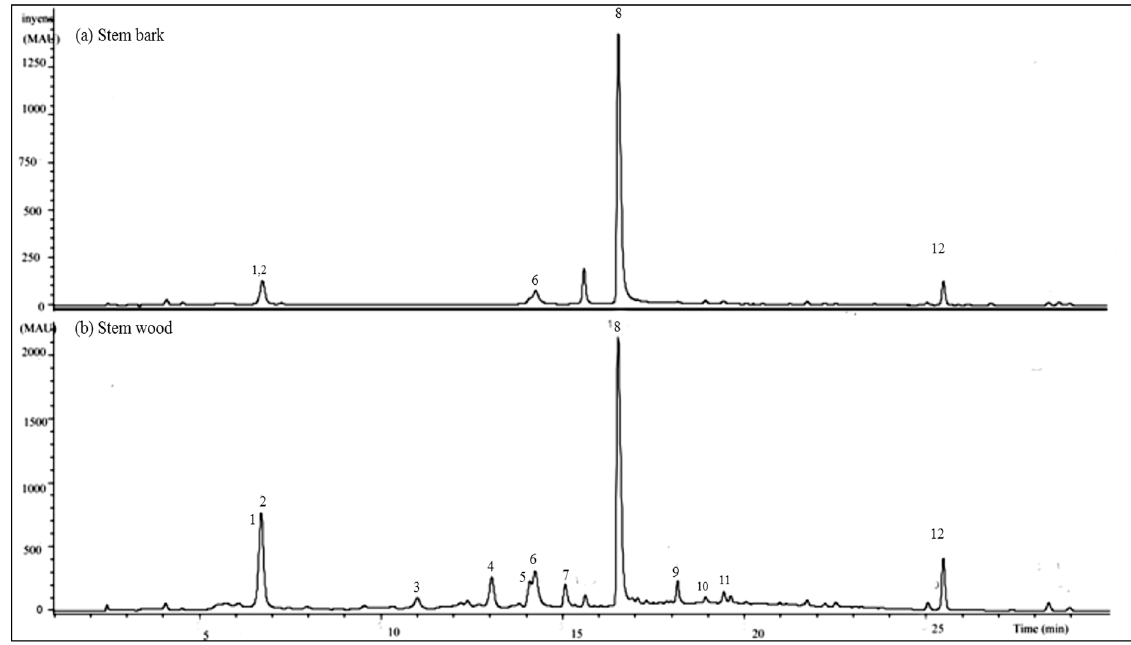
Figure 3. RP-HPLC/DAD chromatograms of ethyl acetate extracts of T.brownii . ( A ) stem bark and ( B ) stem wood extracts at 254 nm. ( 1 ) and ( 2 ) Oleanane type triterpenoids; ( 3 ) cis-resveratrol-3- O - β -galloyl-glucoside; ( 4 ) trans-resveratrol-3- O - β -galloyl-glucoside; ( 5 ) Methyl-( S ) - flavogallonate; ( 6 ) Gallagic acid dilactone (Terminalin); ( 7) Naringenin-4 ′ -methoxy-7-pyranoside; ( 8 ) Quercetin-7-ß- O -diglucoside; ( 9 ) Corilagin derivative; ( 10 ) Quercetin-7- O -galloyl-glucoside; ( 11 ) unknown ellagitannin; ( 12 ) 5,6-dihydroxy-3 ′ ,4 ′ ,7-trimethoxy flavone.